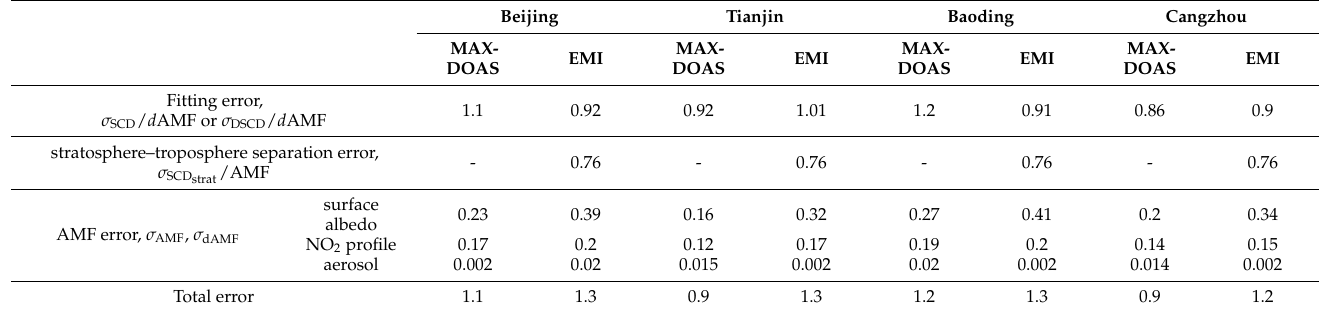
Table 3. Error in the retrieval of tropospheric vertical NO 2 column from EMI and MAX-DOAS (10 15 molecules cm − 2 ). Beijing Tianjin Baoding Cangzhou MAX-